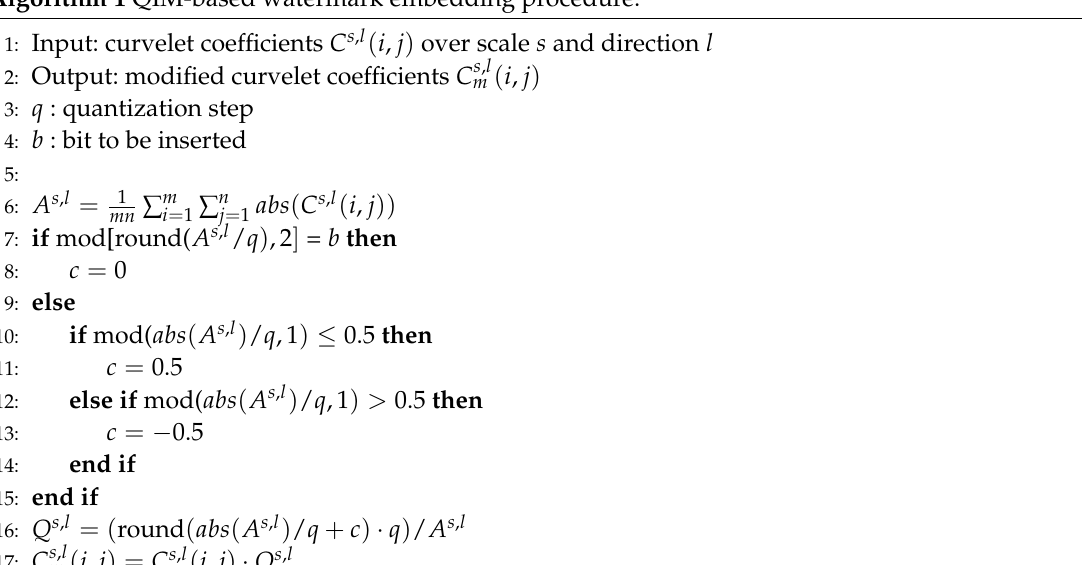
Algorithm 1 QIM-based watermark embedding